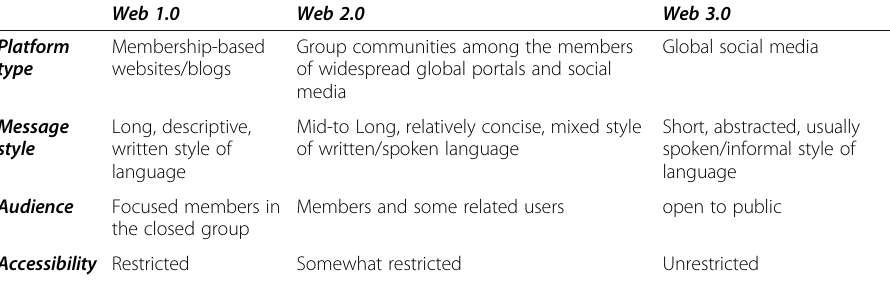
Table 1 Different generations of Online Social Networks and their main characteristics Web